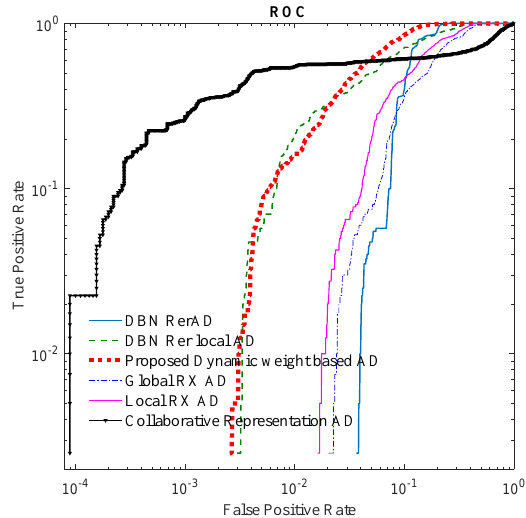
Figure 12. The ROC of San Jose HSI image